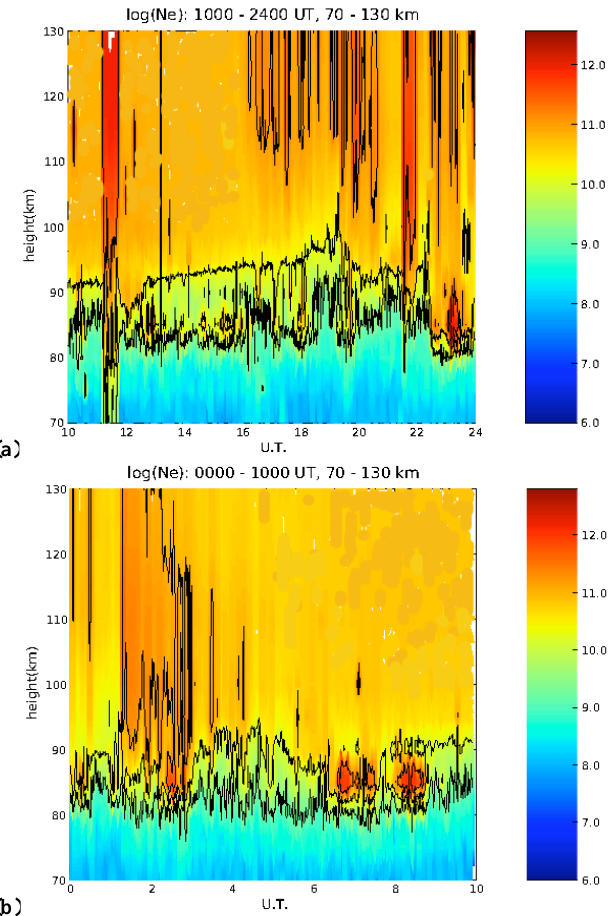
Fig. 1. D-region electron density observed with the EISCAT VHF radar on 1 and 2 July 2005. The time resolution is about a minute. Contours are marked at 10 9 , 10 10 and 10 11 m − 3 .